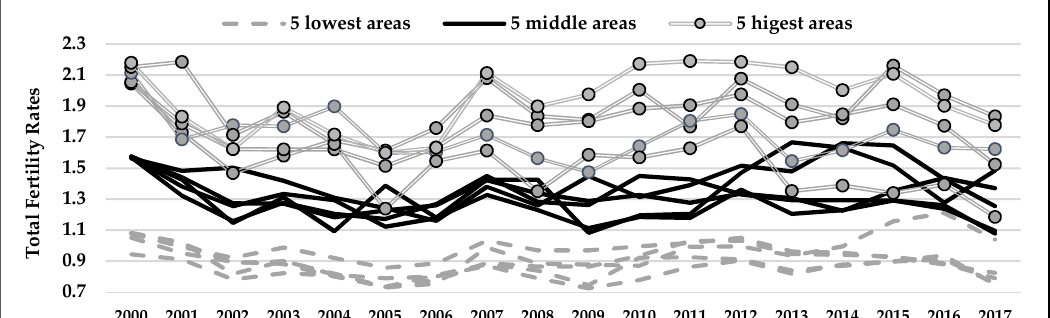
Figure 1. Fluctuation of local-level total fertility rates (TFRs).